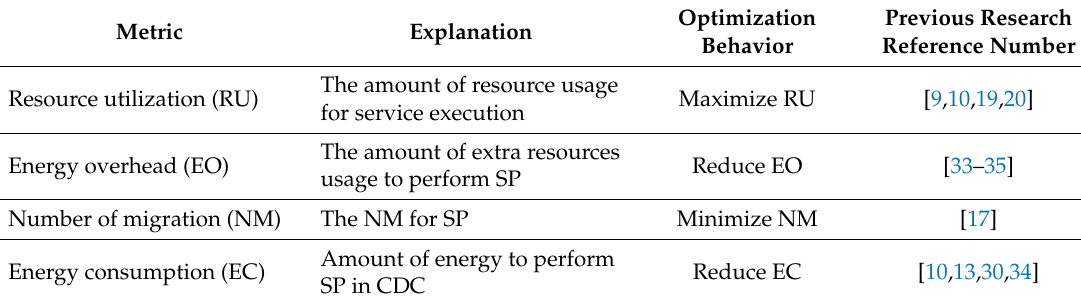
Table 4. Energy e ffi ciency